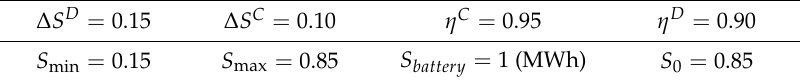
Figure 3. The power production of the photovoltaic (PV) with an average of 500 paths. Table 1. The characteristics for the energy storage system (ESS).